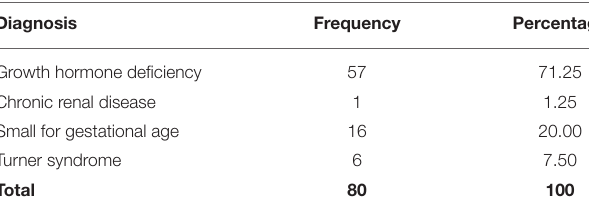
TABLE 2 | Distribution of diagnoses in the study